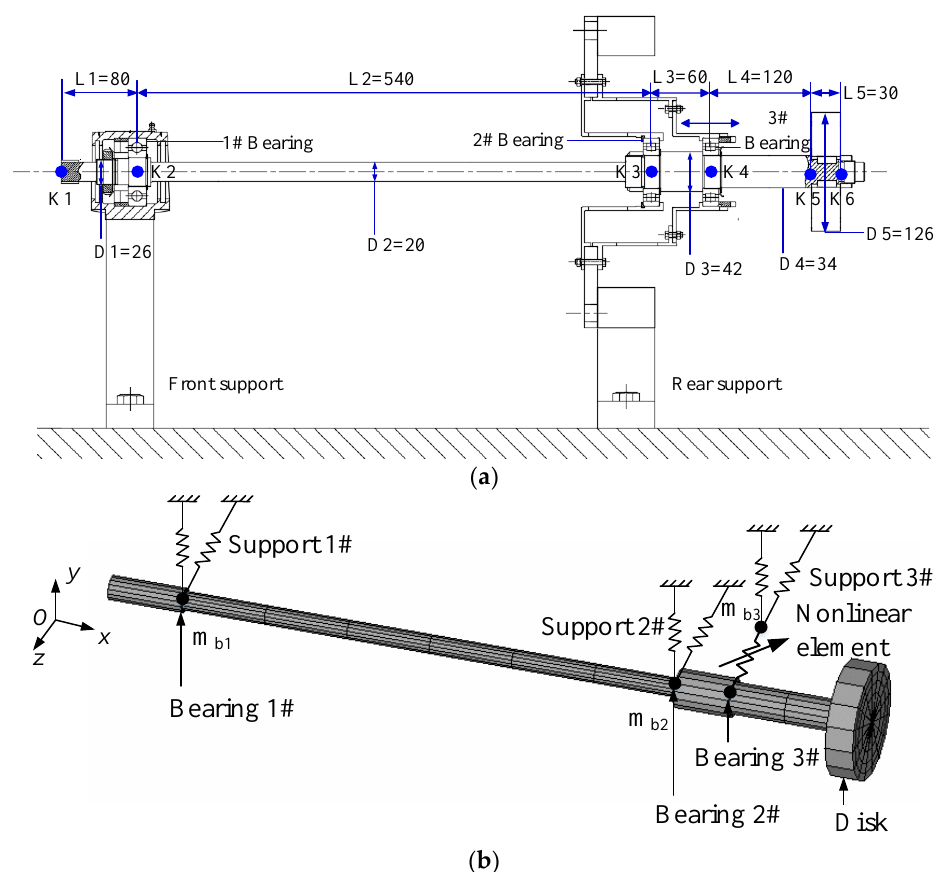
Figure 18. The flexible rotor – support system with three bearings and an overhanging disk: ( a ) structure and parameters; ( b ) nonlinear finite element model.